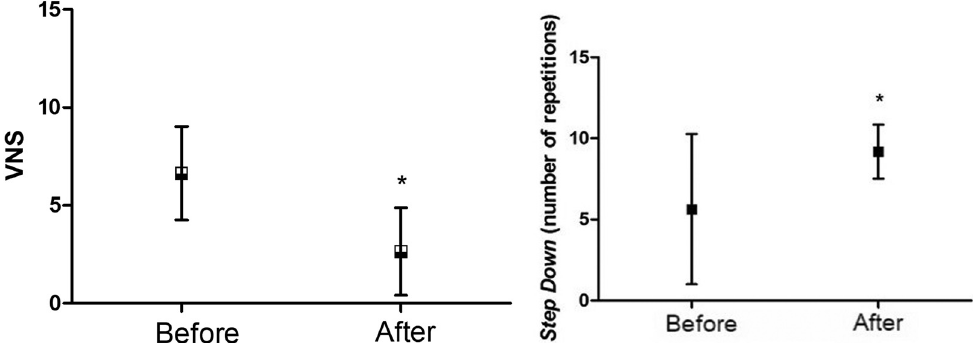
Figure 4 - Graphs of the visual numeric scale (VNS) and step-down test (number of repetitions) data before and after the application of the interven- tion protocol. *indicates statistically significant difference (p < 0.05).